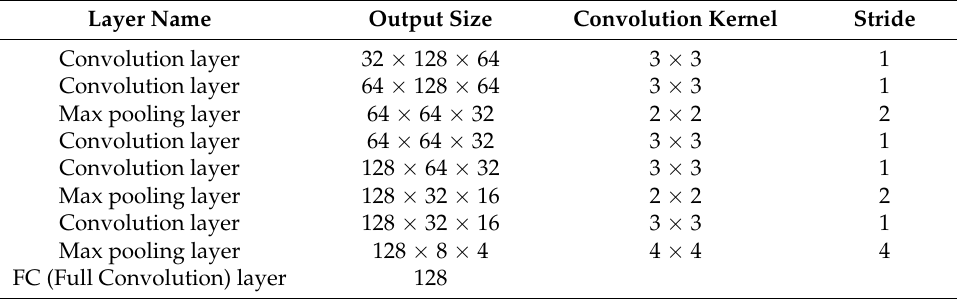
Table 1. The neural network structure of deep feature